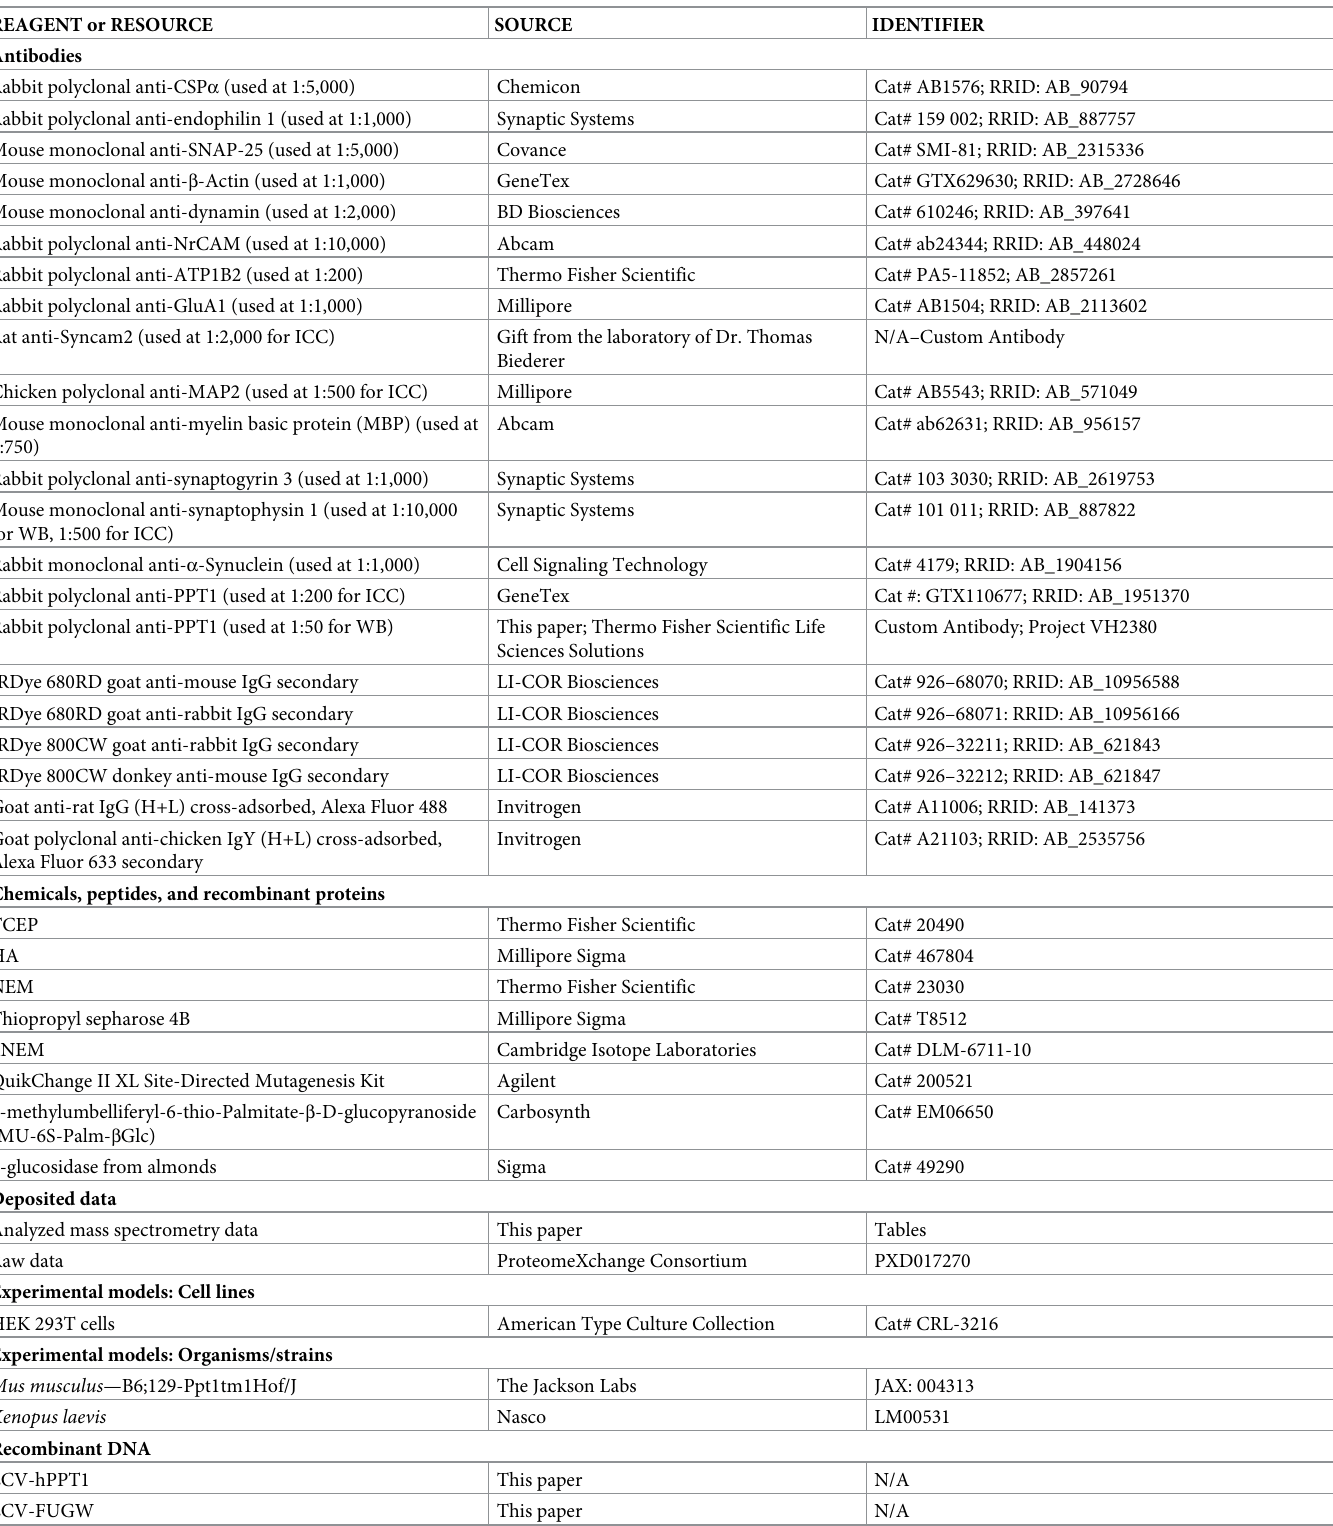
Table 3. Key reagents and